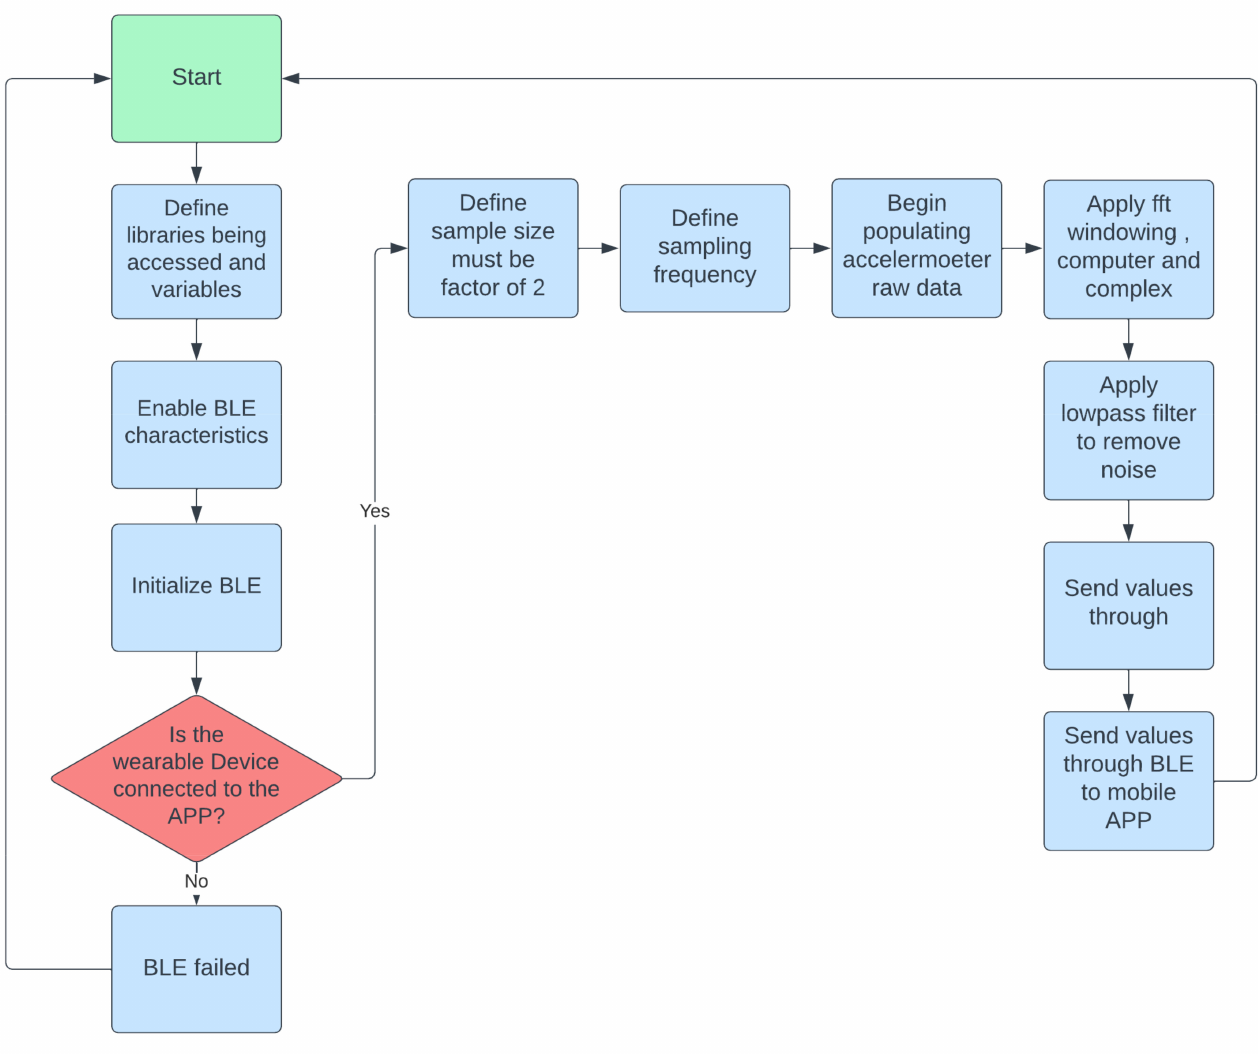
Figure 5. DiAtack wearable band software